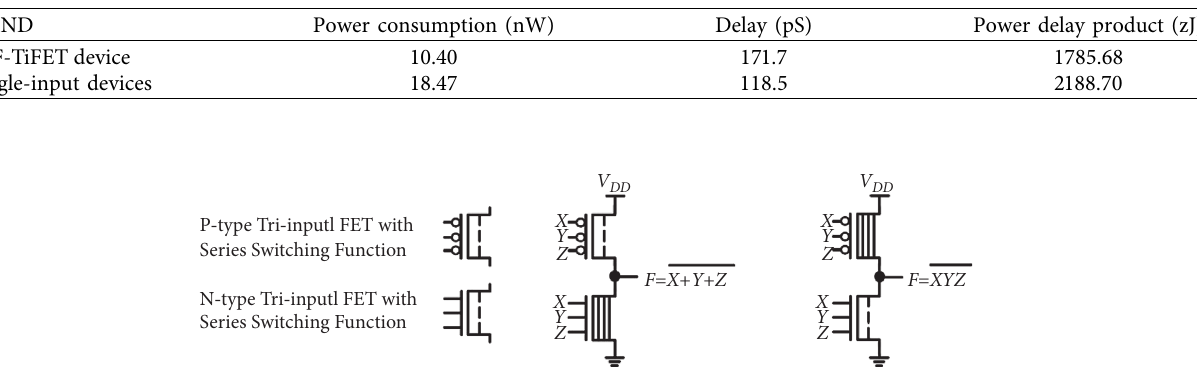
Figure 17: The three-input NOR gate and the three-input NAND gate based on the devices with series switching function and PSF-TiFET